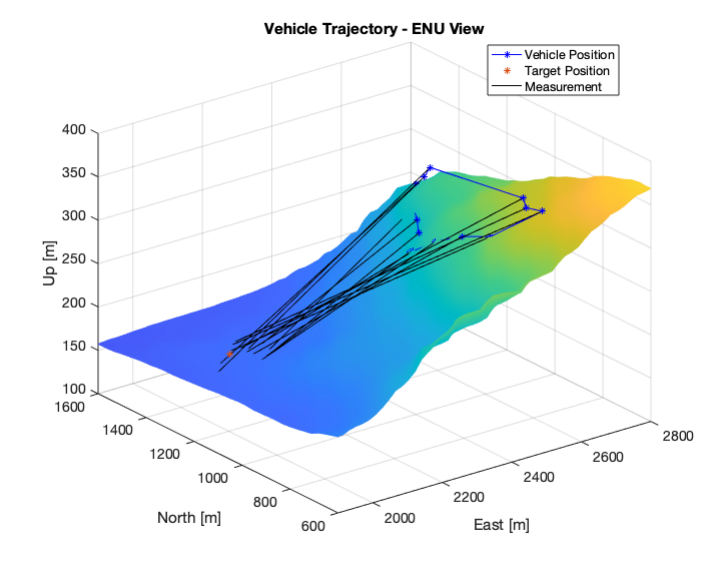
Figure 12. Trajectory and IRT results in local ENU coordinate system